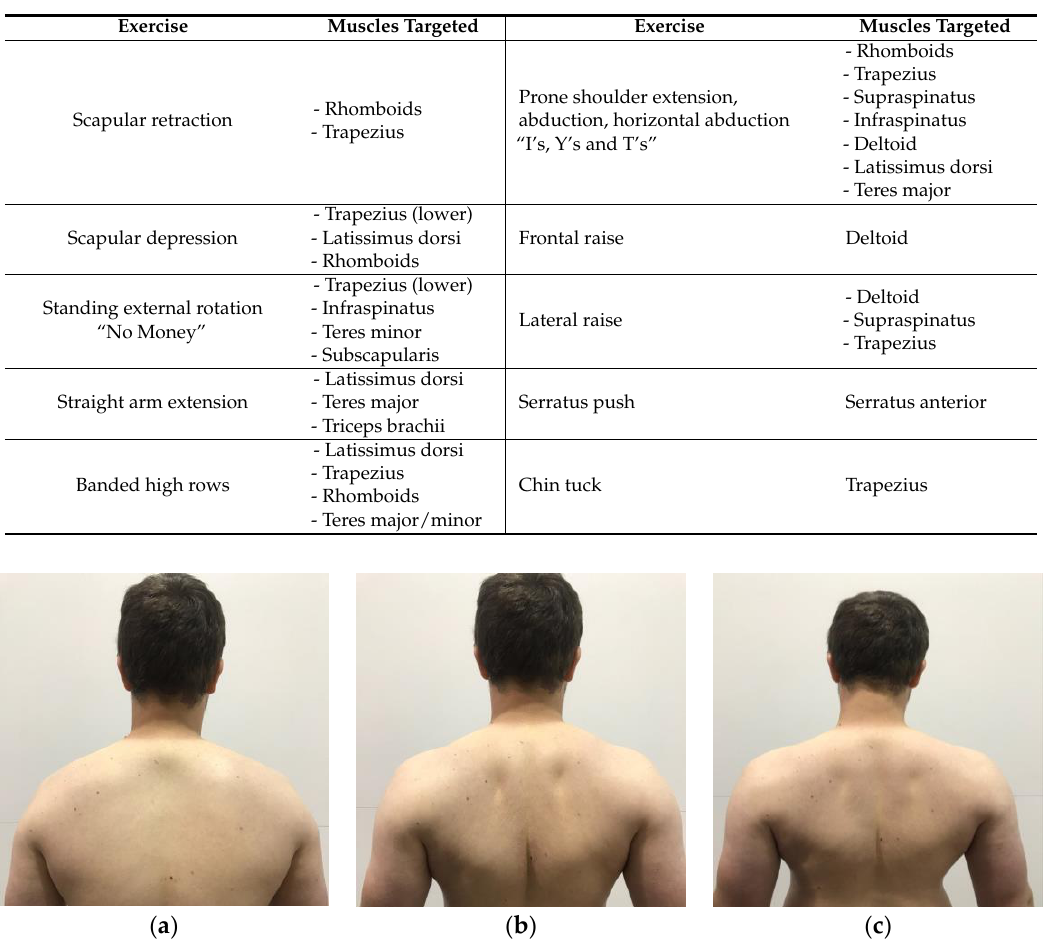
Table 2. Summary of suggested exercises to target shoulder and scapular musculature.